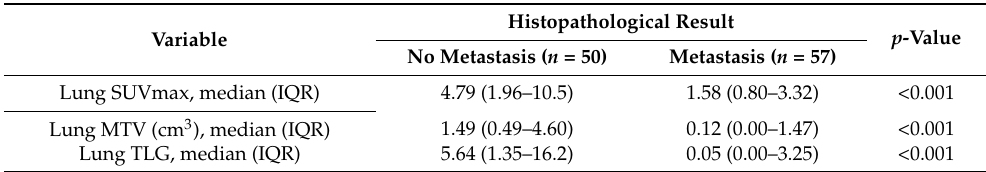
Table 3. Distribution of FDG-PET/CT semi-quantitative body parameters among lesions with and without metastases ( n = 107).